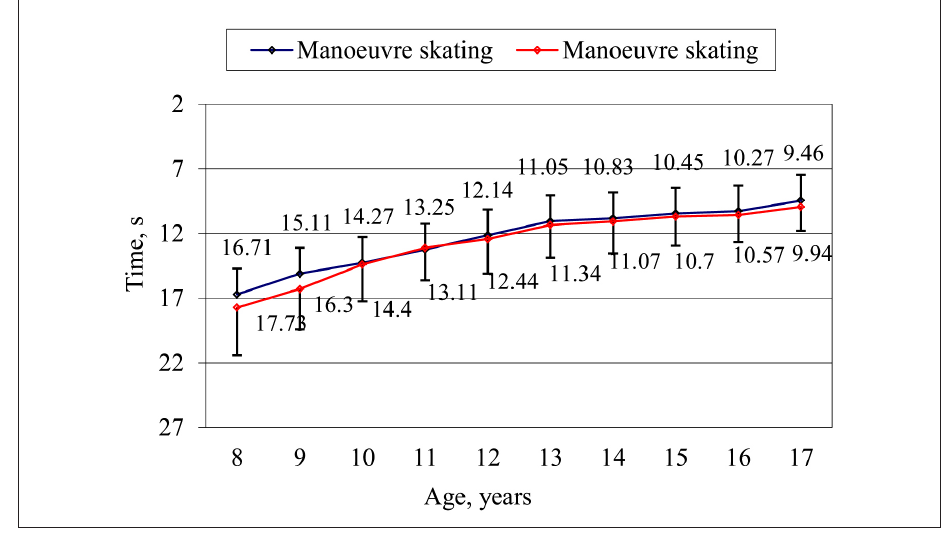
Figure 3. Changes in results of various